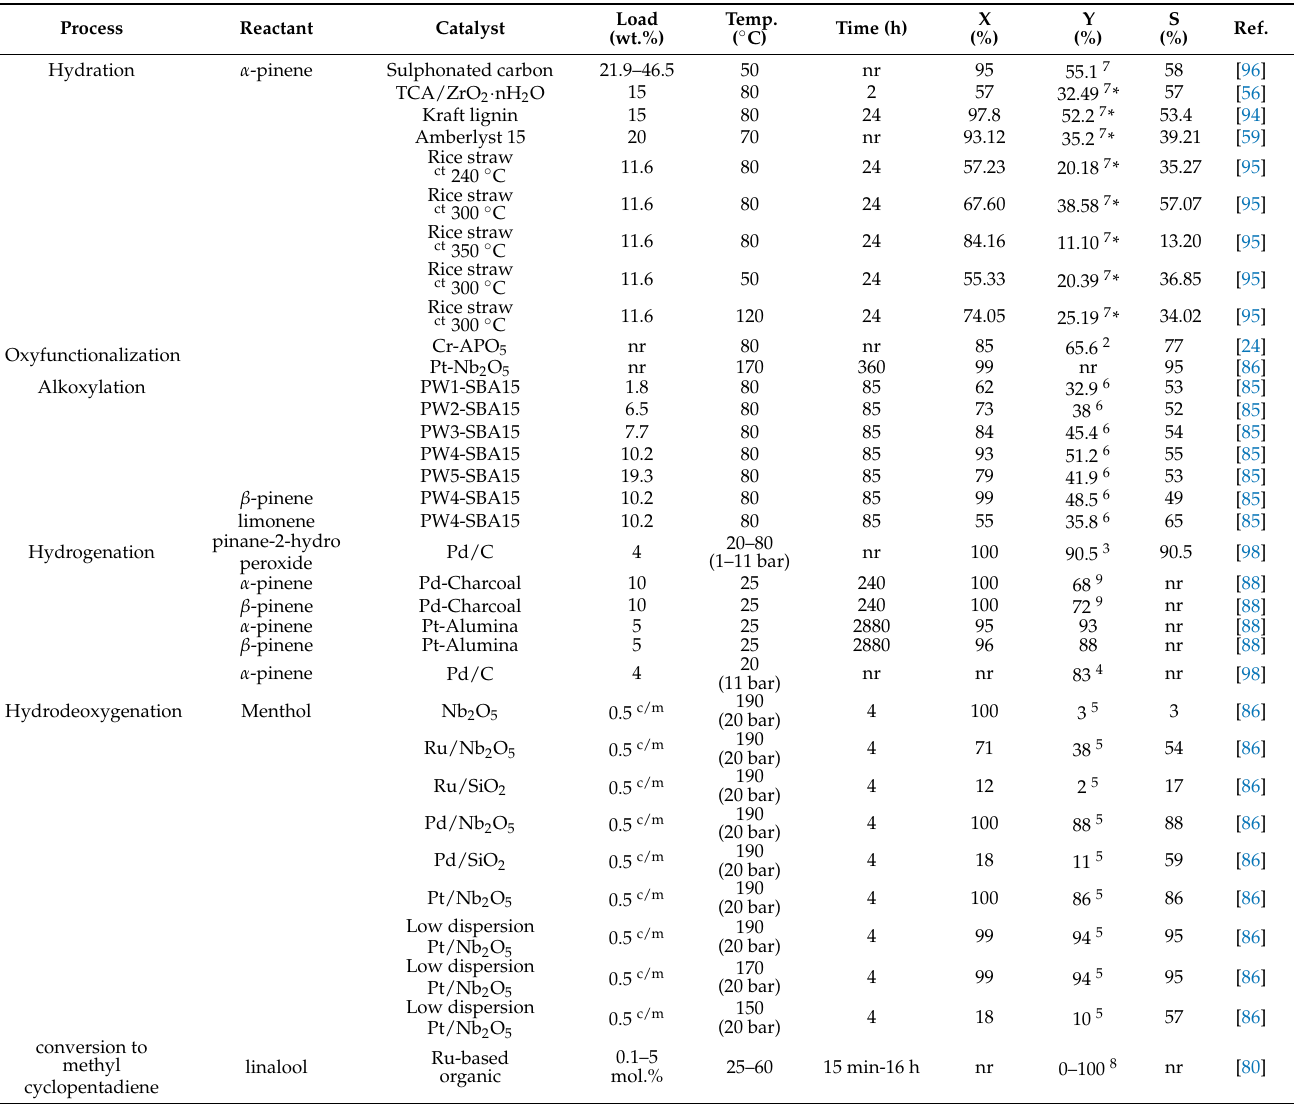
Table 4. Catalytic conversion of terpenes and terpene oxides (1